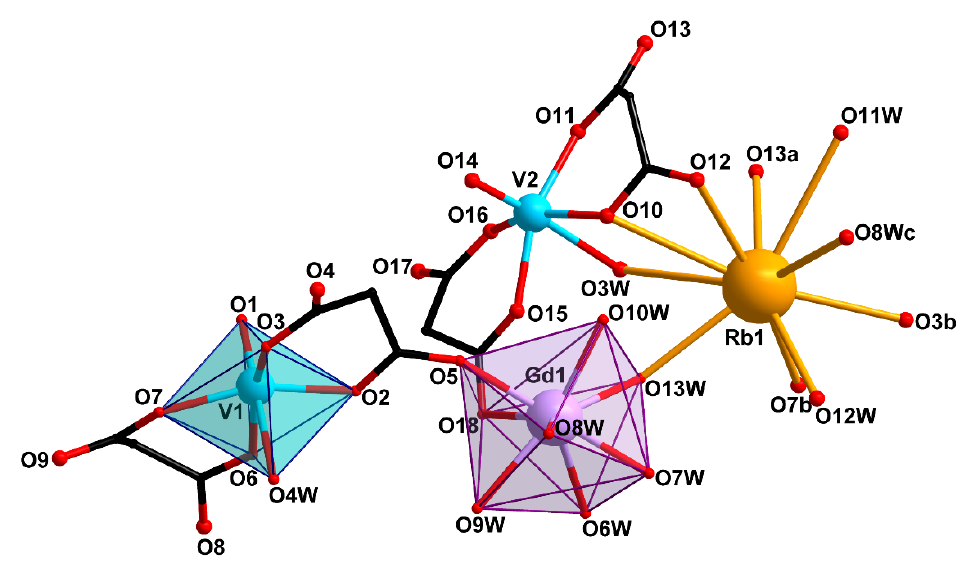
Figure 2. Structure of trinuclear unit {GdV 2 } − and Rb atom environment in compound 2 (H atoms and cyclic fragments of the carboxylate ligands are not shown). [Symmetry codes: (a) 1 − x, y, 1.5 − z; (b) − 0.5 + x, 0.5 + y, z; (c) 1 − x, 2 − y, 1 − z].